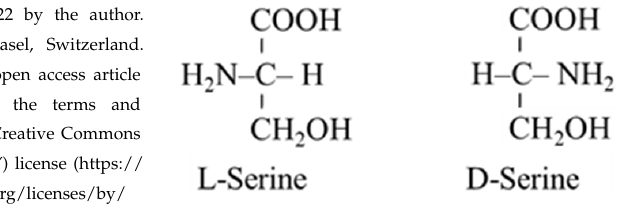
Figure 1. Chemical structures of L-serine and D-serine.